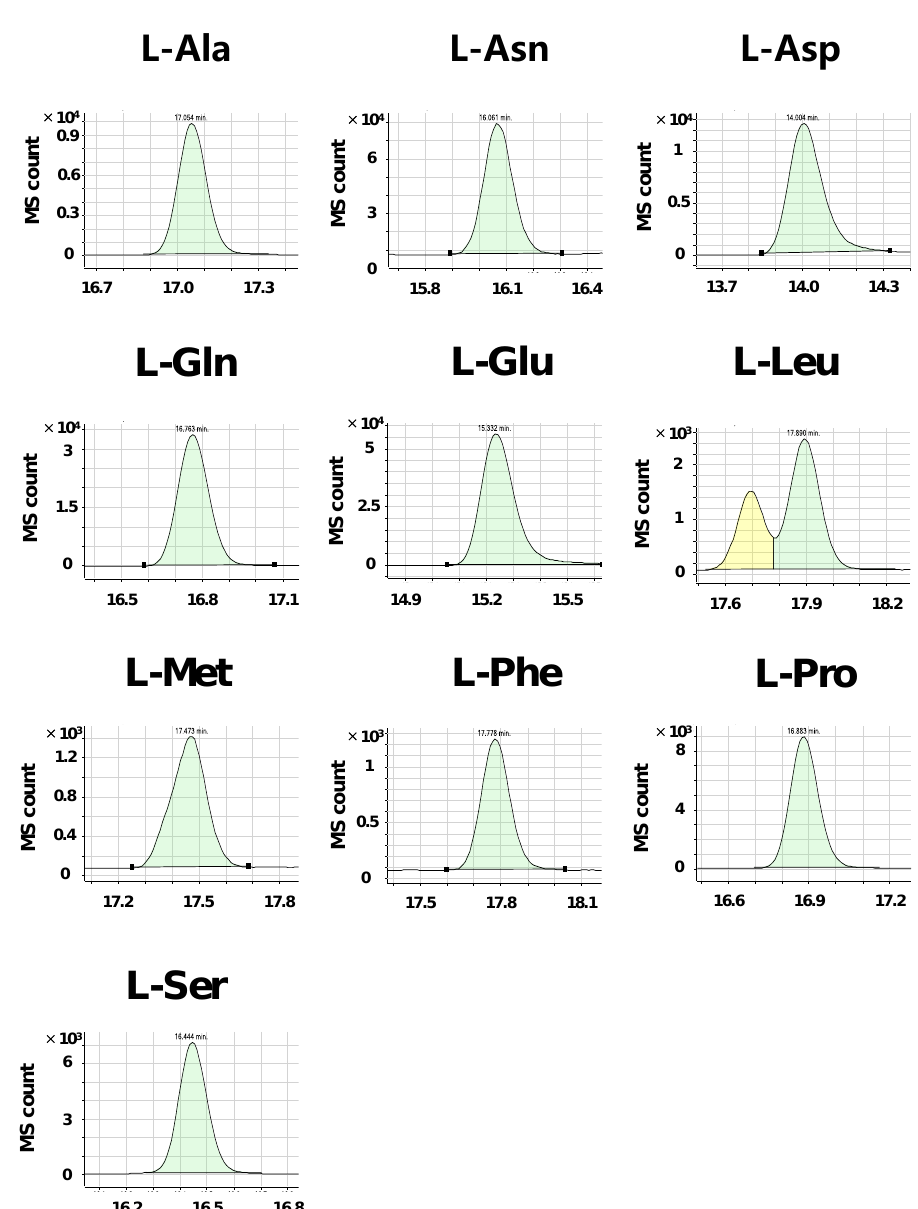
Figure 3. Chromatograms of derivatized L -amino acids in the murine cortex samples. Tissue samples were extracted from the cortices of 3-month-old mice. Representative MRM chromatograms of derivatized L -amino acids are shown. In each panel, relative ion abundance (MS counts) versus retention time (min) are shown. Integrated MS count (green) represents the amount of target